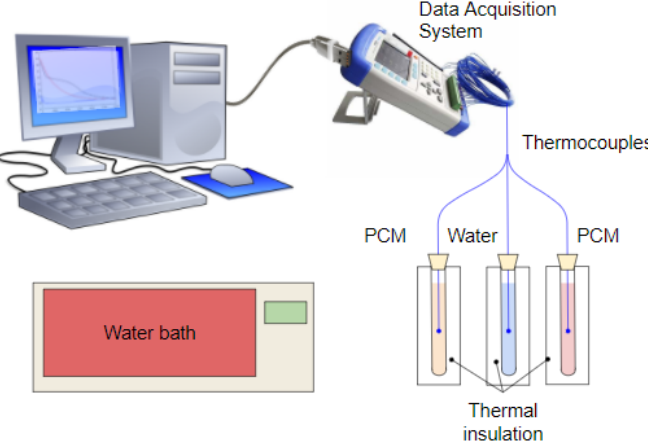
Figure 2. Scheme of the experimental setup for the implementation of the T-history method in cooling